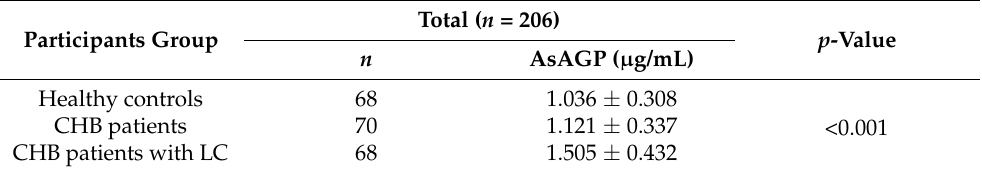
Table 2. Serum AsAGP levels in respective groups.